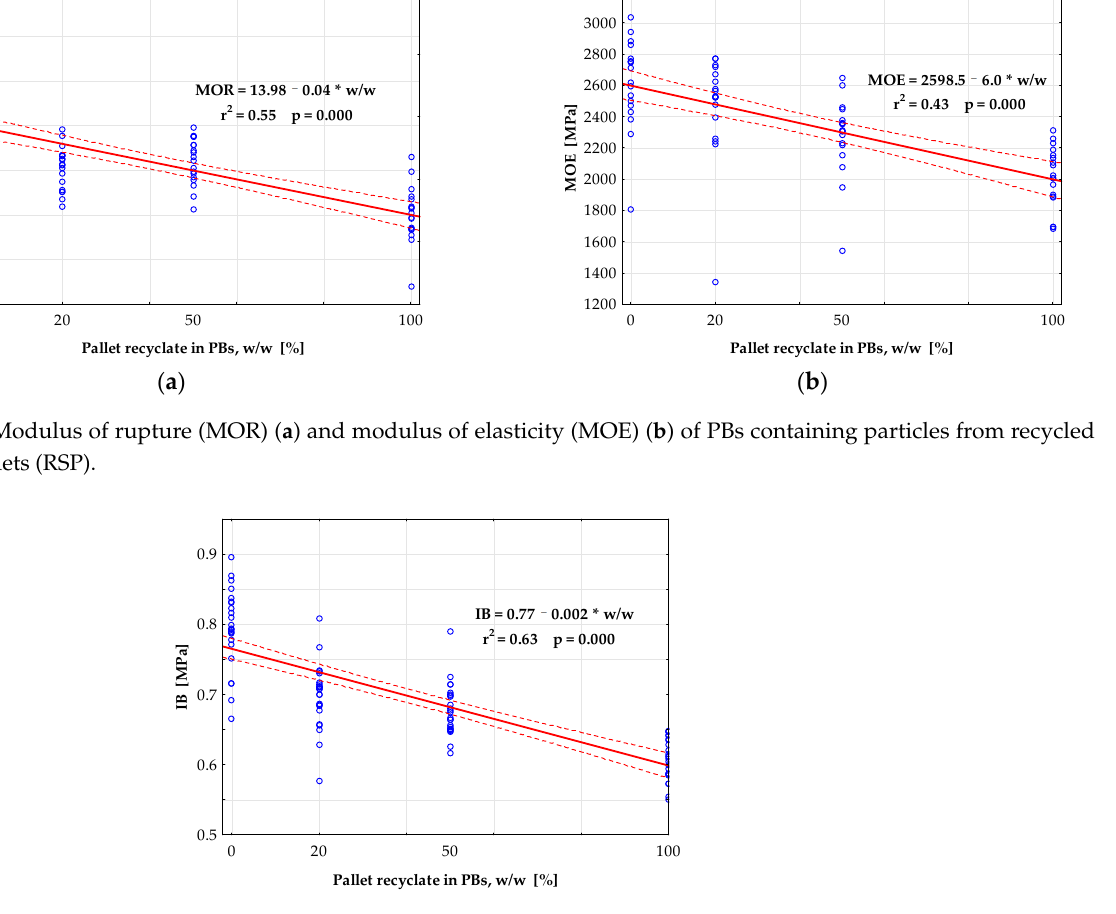
Figure 8. Internal bond (IB) of PBs containing different amount of particles from recycled spruce pallets (RSP).